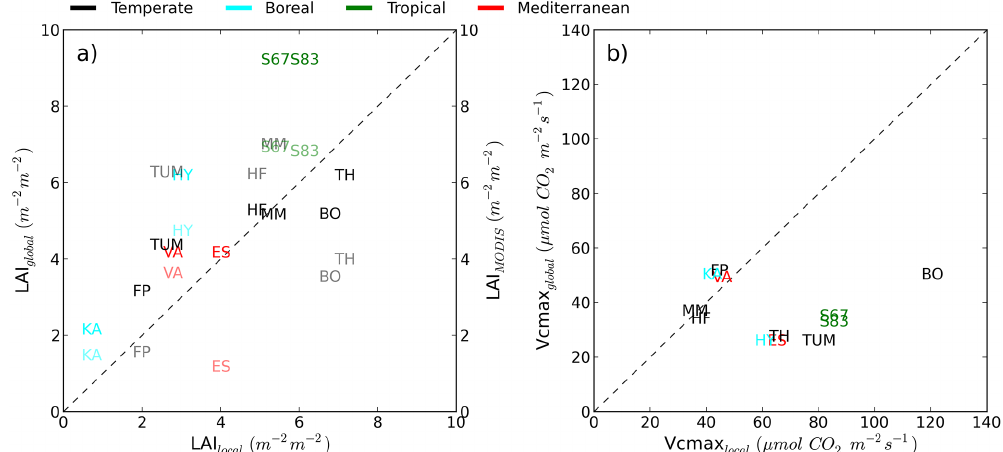
Figure 6. Comparison of (a) global, MODIS (site annual maximum) and local leaf area index (LAI) and (b) global and local maximum rate of Rubisco carboxylase activity ( V cmax ) at the 12 FLUXNET sites (HF: Harvard Forest; VA: Vaira Ranch; MM: Morgan Monroe; HY: Hyytiala; TH: Tharandt; TUM: Tumbarumba; ES: El Saler; FP: Fort Peck; KA: Kaamanen; S67: Santarem Km67; S83: Santarem Km83; BO: Bondville). The LAI data displayed for each study site refer to the annual maximum LAI of the dominant PFT. The site labels are coloured according to their climate zone (Table 2) and in (a) , the lighter shades are the MODIS data. The dashed grey lines represent LAI and V cmax , where global, MODIS and local values match, with overestimated global and MODIS values above the dashed line and underestimated values below